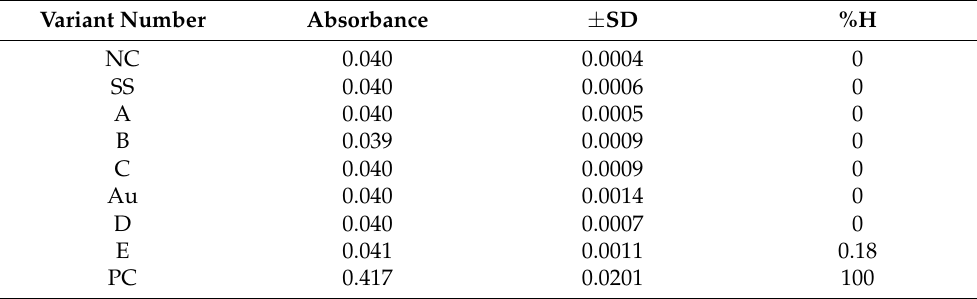
Table 2. Results of hemolysis degree of obtained GO coatings in comparison to uncoated steel and gold.